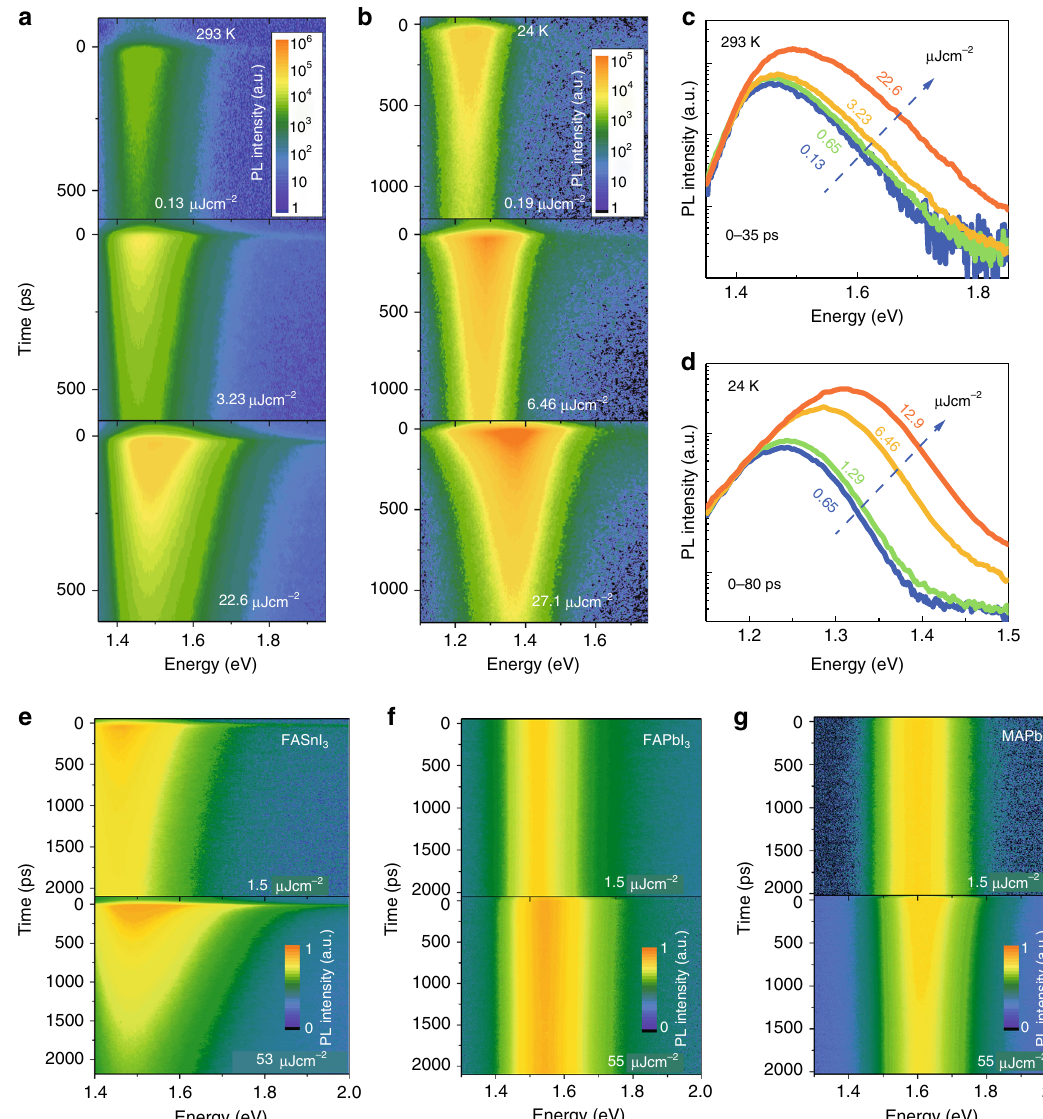
Fig. 3 Power-dependent time-resolved photoluminescence revealing long-lived hot carriers. a , b Energy-resolved and time-resolved photoluminescence of FASnI 3 thin fi lms pumped with different laser intensities at 293 and 24 K, respectively. Semi-log plot of PL spectra immediately after excitation under 3.1 eV pump excitation at different intensities at c 293 K and d 24 K. PL spectra are taken by integrating the time pro fi le from 0 to 35 ps and 0 to 80 ps for 293 and 24 K, respectively. The corresponding excitation densities are indicated. The PL spectra have been normalized at the low-energy tail to show the hot carrier PL clearly. e – g Energy-resolved and time-resolved photoluminescence spectra of perovskite thin fi lms at low and high excitation density for FASnI 3 , FAPbI 3 , and MAPbI 3 , showing that the FASnI 3 thin fi lms exhibit much stronger band- fi lling effect and prolonged hot carrier